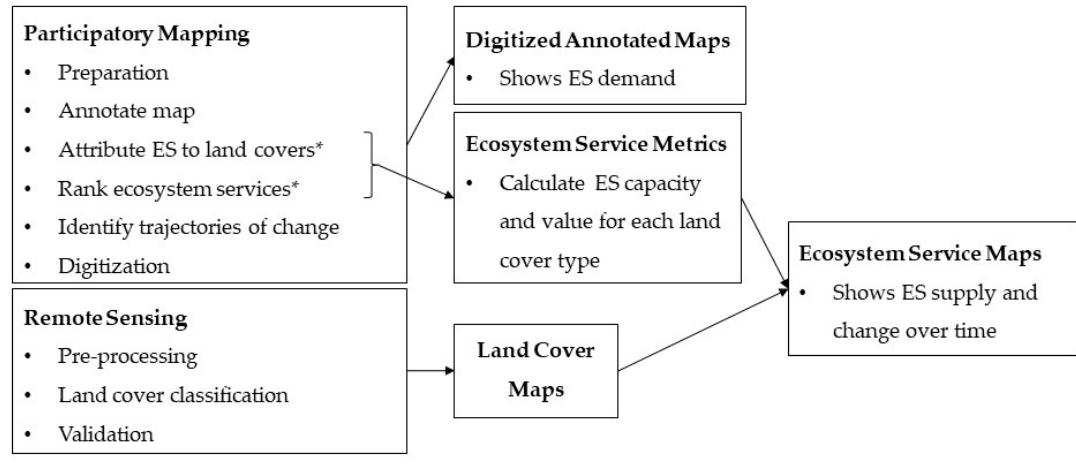
Figure 2. The proposed methodology for integrating participatory mapping and remote sensing to produce ecosystem service maps. The results from participatory mapping annotated with * were used as weights in the metrics and for generating provisioning ecosystem service maps.